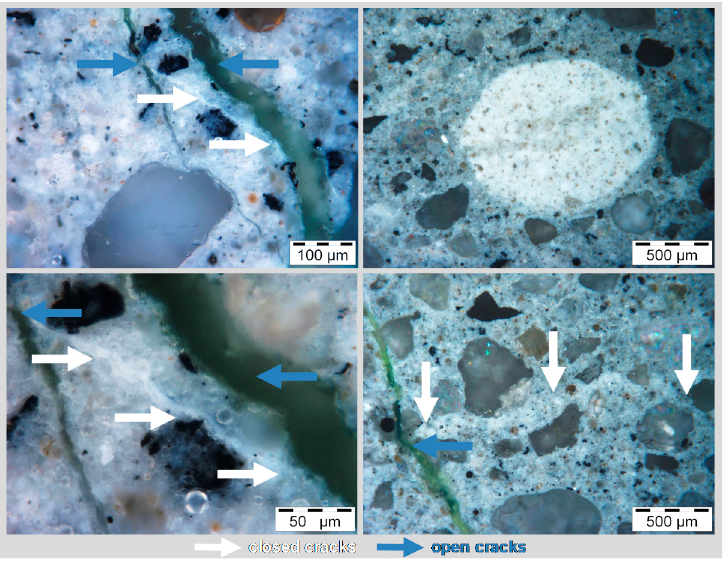
Figure 18. Cross section of tests specimen F1gB after one year of exposure; closed cracks and pores. Blue: main cracks, open; white: transverse cracks, closed.